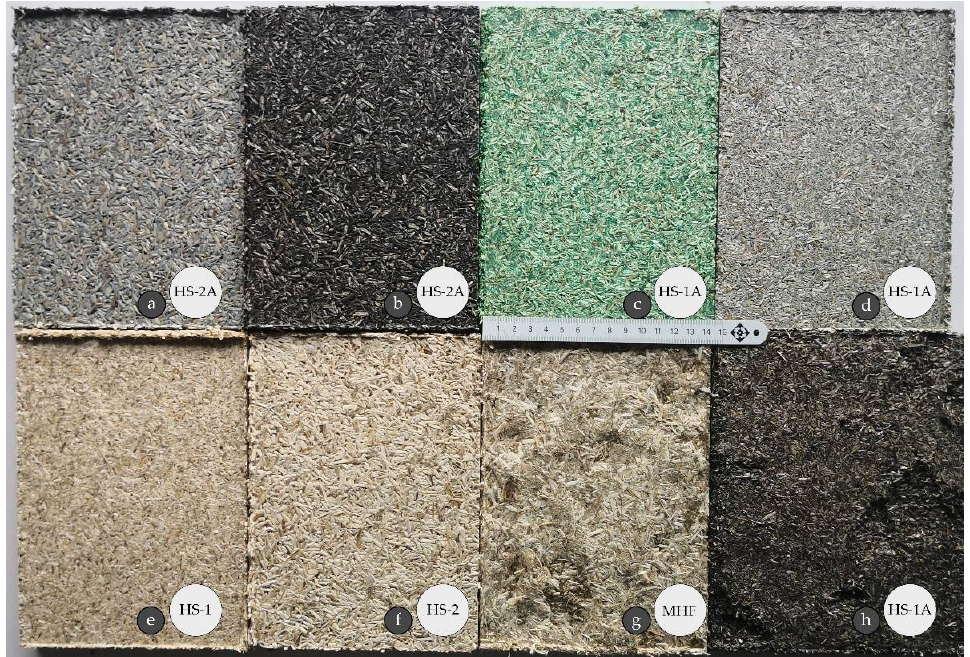
Figure 4. Surface view of board samples: ( a ) HS-2A sample with water-based wood coating applied on HS; ( b ) HS-2A sample with acrylic colorant applied during mixing process; ( c ) HS-1A sample with oil-based coating applied on HS; ( d ) HS-1A sample with water-based wood coating applied during mixing process; ( e ) HS-1 board sample; ( f ) HS-2 board sample; ( g ) MHF board sample; ( h ) HS-1A with oil-based coating applied on HS.